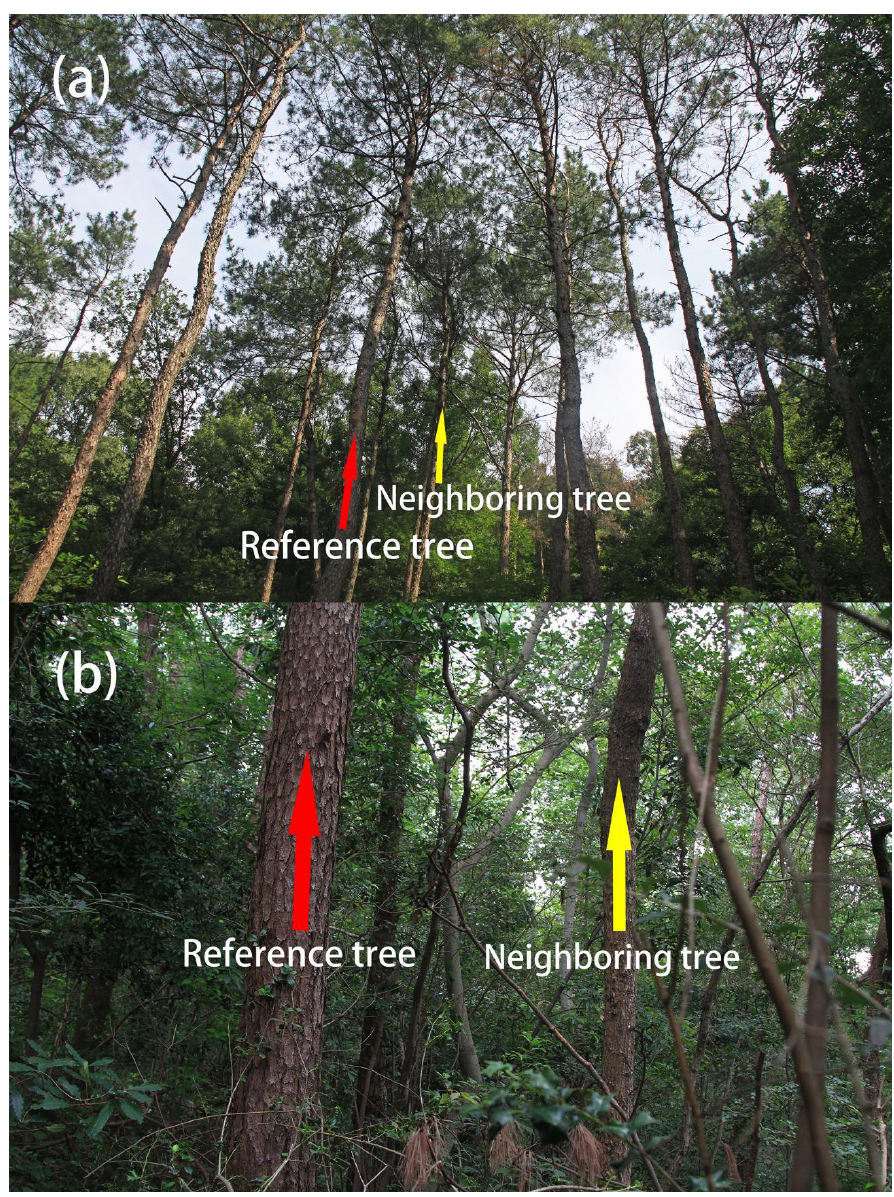
Figure 2. Reference tree Masson pine and its neighboring trees of a pine forest ( a ) in Longtan, Liyang, and counterparts of a mixed forest ( b ) in Purple Mountain, Nanjing, China. Reference and neighboring trees are indicated by the red arrows and the yellow ones, respectively. The photographs were provided by Guangfu Zhang.